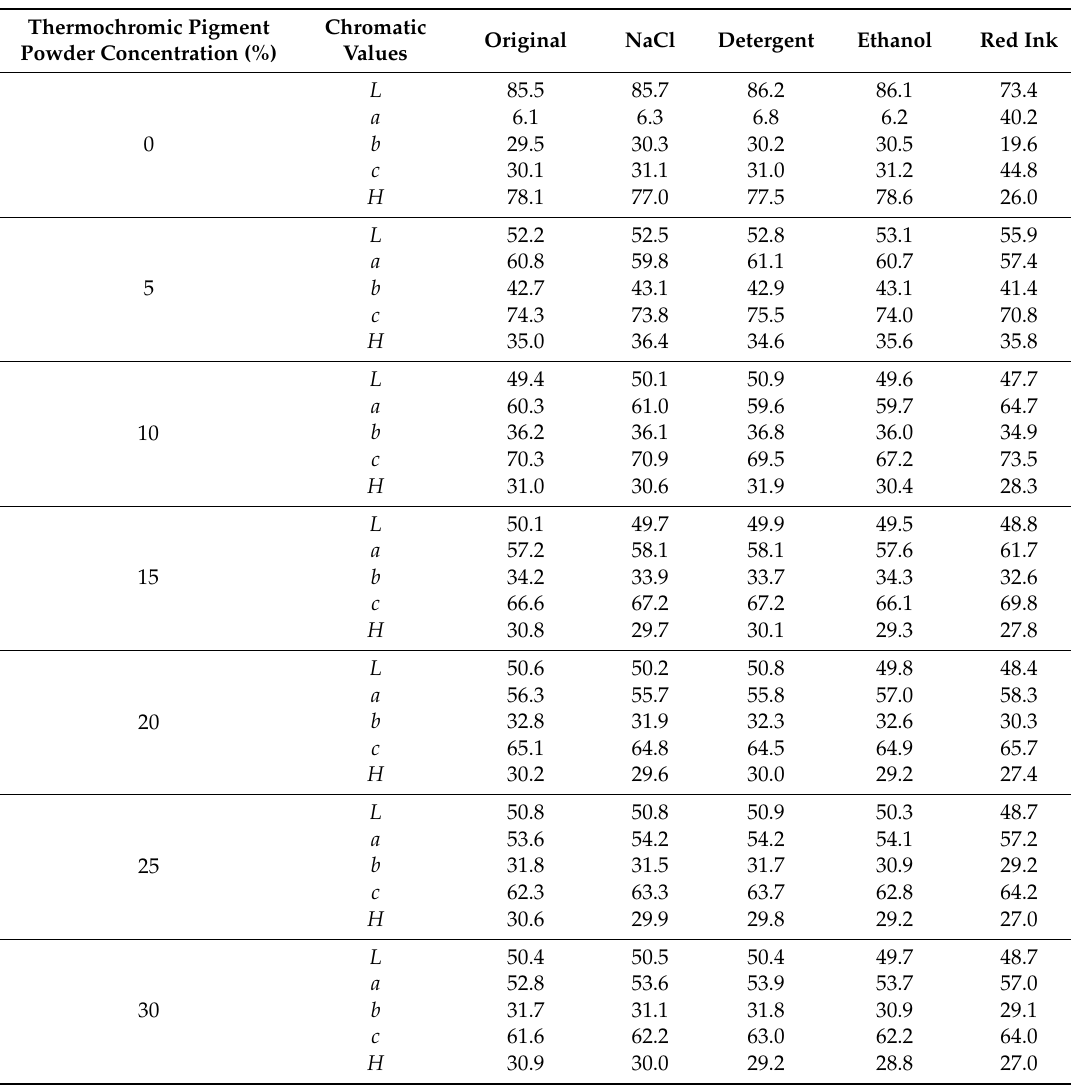
Table 7. Influence of di ff erent concentrations of the thermochromic pigment powder on the color variation of the primer paint film.